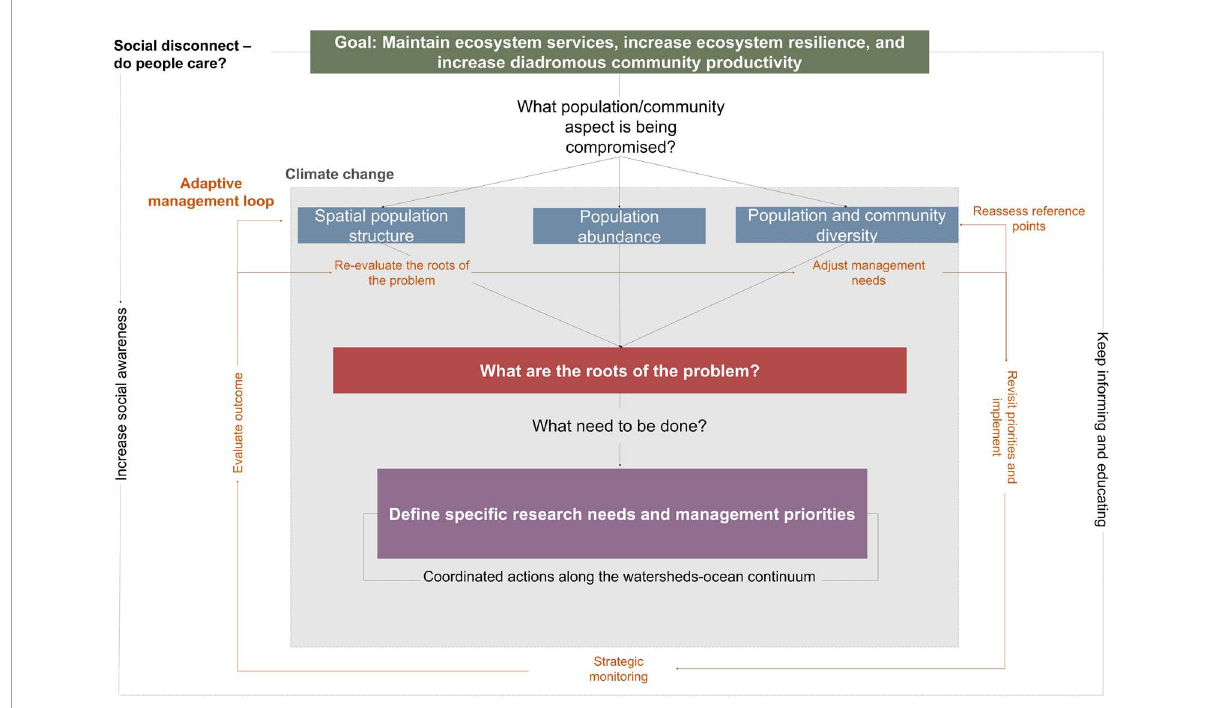
FIGURE8 Diadromous Watersheds-Ocean Continuum (DWOC) roadmap for ecosystem-based management implementation to foster increased diadromous community productivity, resilience, and improved ecosystem services delivery. Climate change affects all aspects of the diadromous community across all spatial scales. As the management process (e.g., evaluation of the roots of the problem, management actions implementation) progresses, there is a need to adopt an adaptive management approach where the situation is reassessed, and management approaches are modified accordingly. The question of if people care is an ongoing issue that may be directly related to willingness to support ongoing management